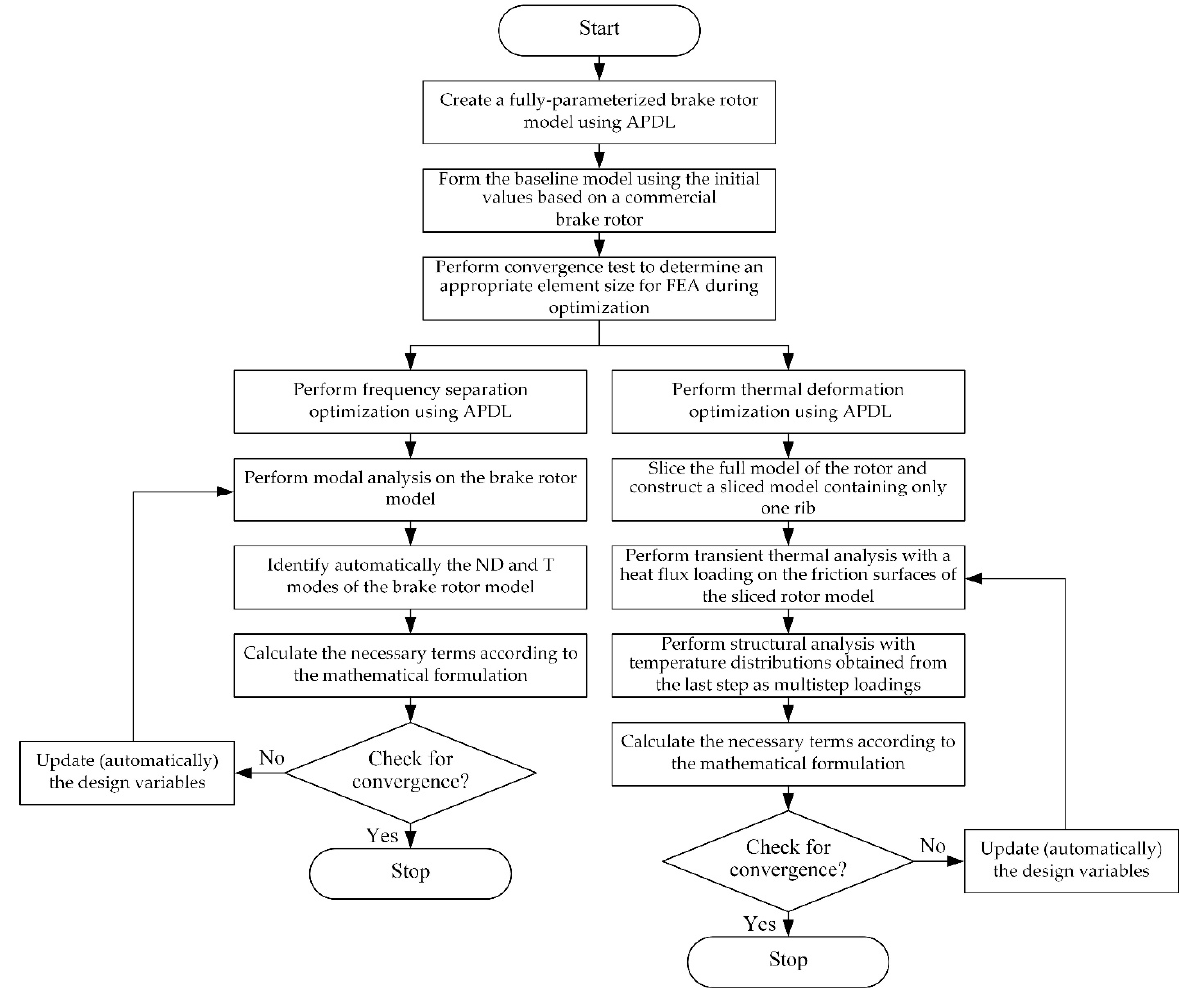
Figure 1. Flowchart for this research.